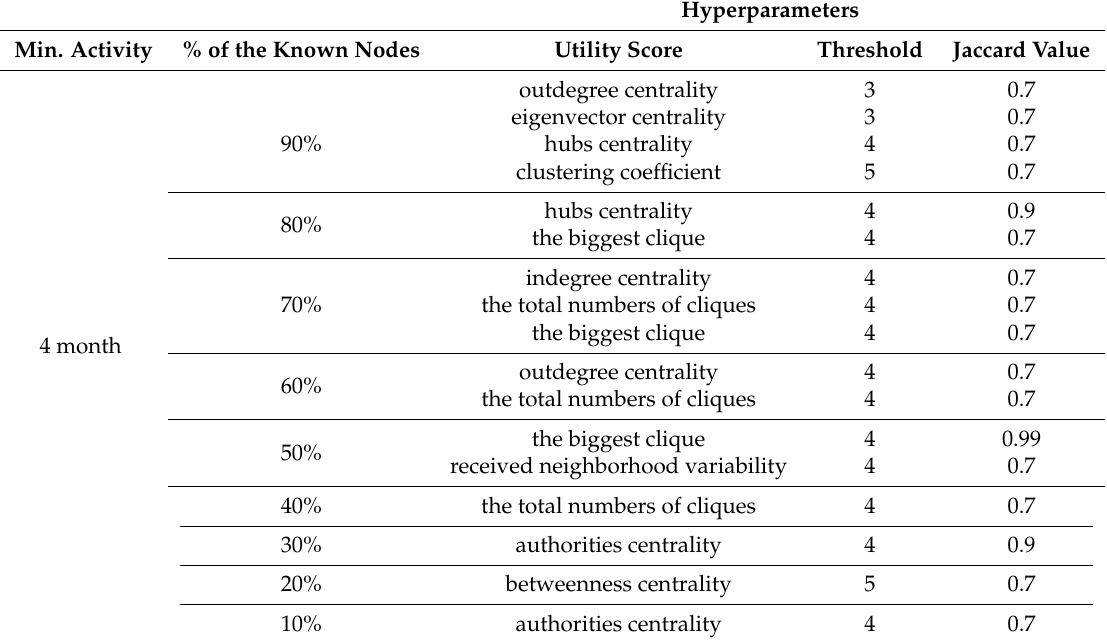
Table A28. The best values of the hyperparameters for the collective classification algorithm for the manufacturing company dataset with two hierarchy levels (4 to 5 months of minimum